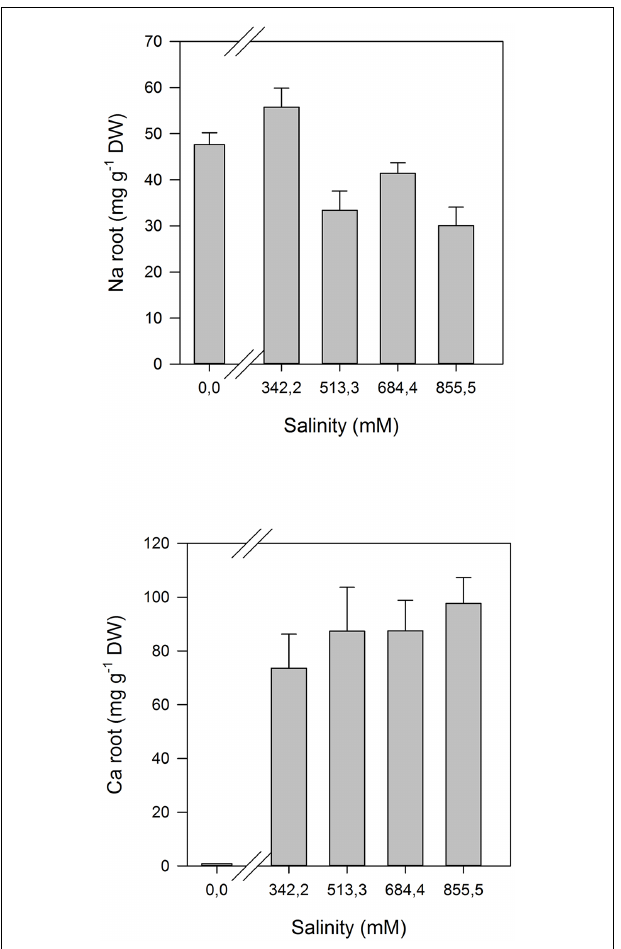
FIGURE 2 | Na + and Ca 2 + ionome in the roots of Sarcocornia fruticosa exposed to increased salinity levels (average ± SE, N = 5).